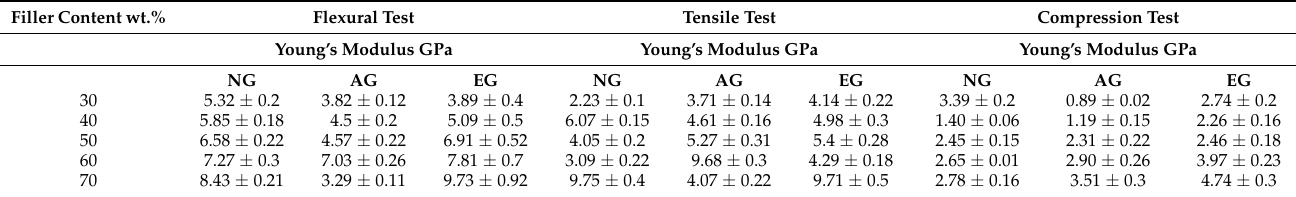
Table 4. Young’s Modulus of PSU-based composites filled with NG, AG and